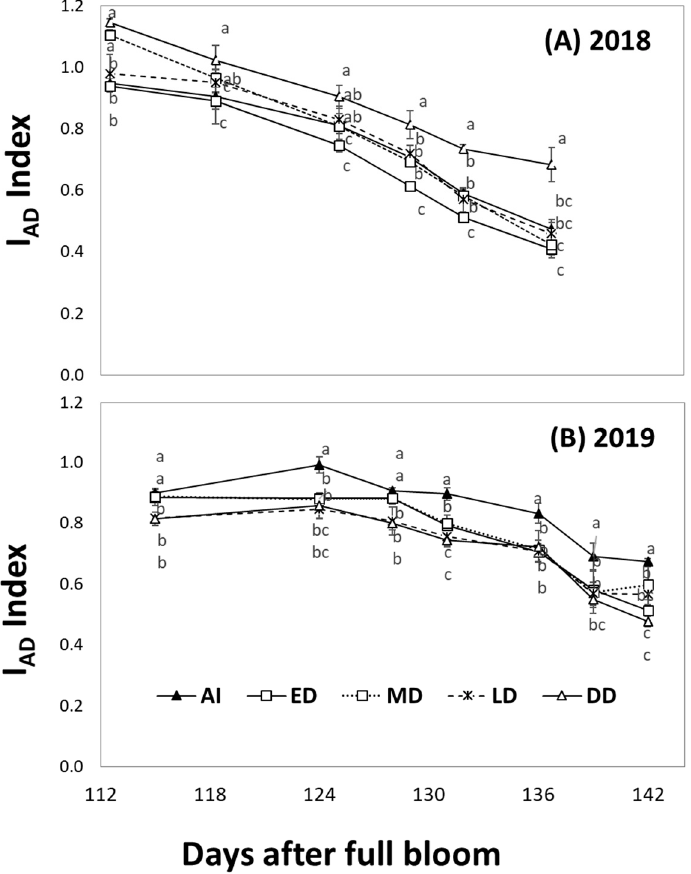
Figure 2. Effects of different irrigations on the loss of chlorophyll in fruit skin measured weekly as the I AD Index of Ambrosia™ apples in a conventional orchard in 2018 ( A ) and 2019 ( B ), respectively. The points are the LS means ± standard error of the mean. Means with different letters within a date are pairwise significant ( p ≤ 0.05) differences. AI = adequate irrigation; ED = early-summer deficit irrigation (DI); MD = middle-summer DI; LD = late-summer DI; DD = double-period DI.